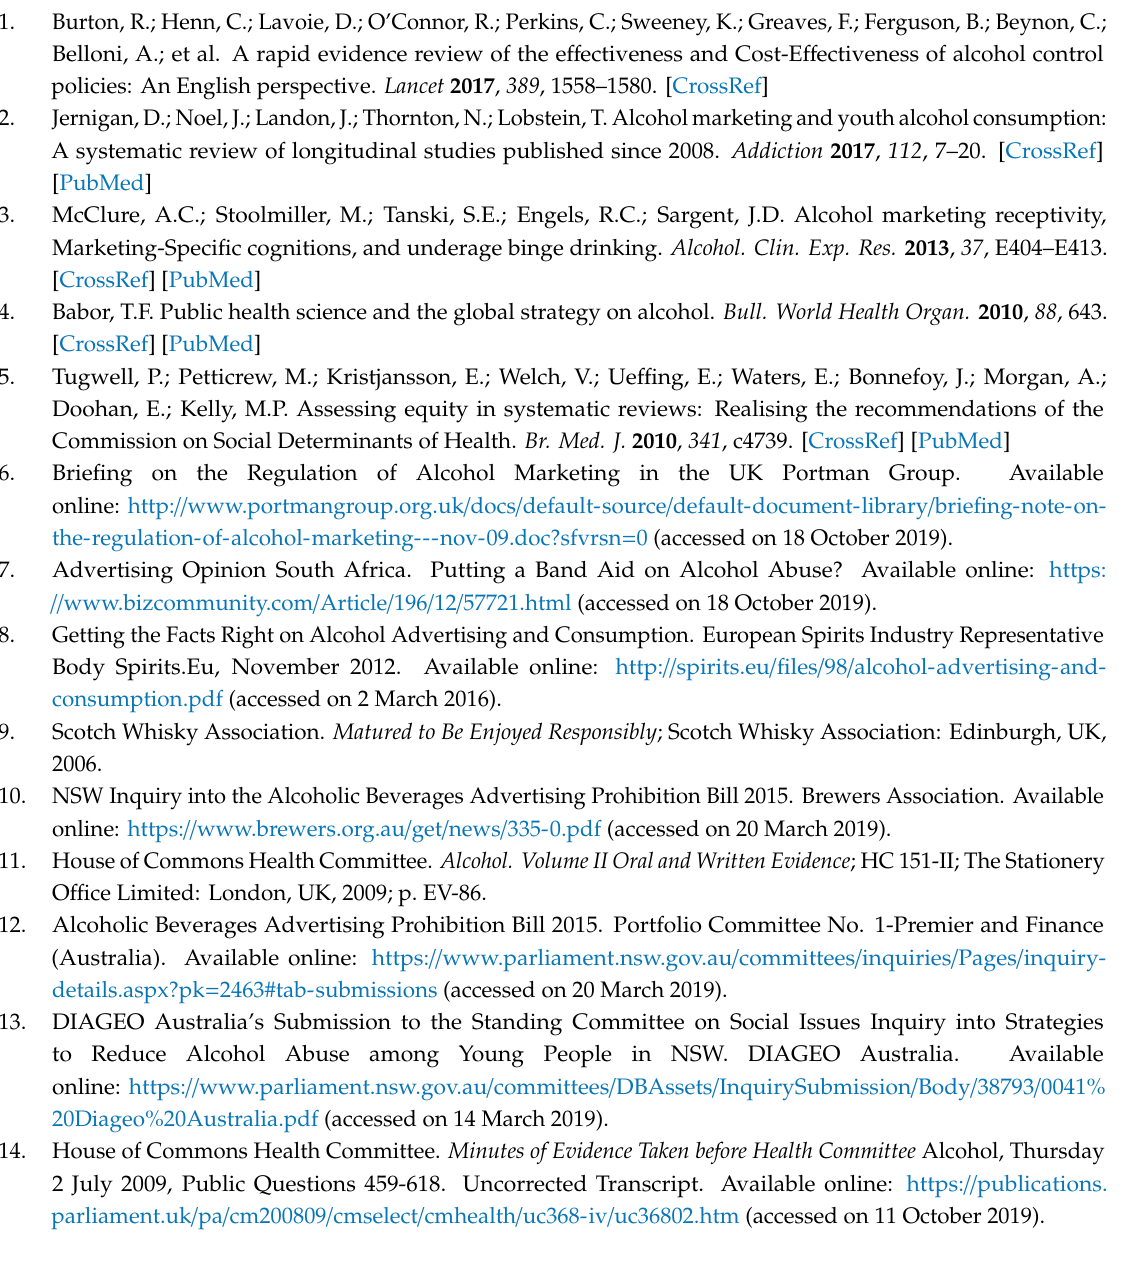
Table S1: Range of e ff ects of advertising identified in these case